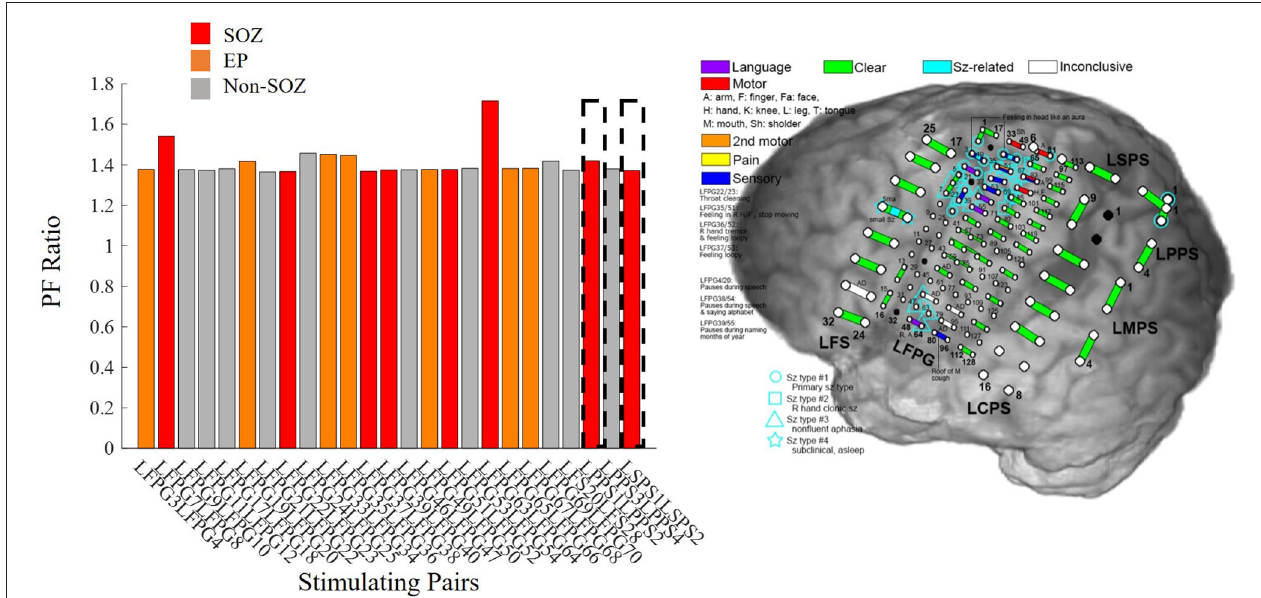
FIGURE 10 | Bar plot of PF ratios for Patient 5 with a high confidence statistic value according to the model, but an unsuccessful surgical outcome. The dotted boxes represent the regions that were resected. Red indicates electrode pairs in the clinically annotated seizure onset zone (SOZ), orange is early spread (EP), and gray are all others. Regions with high PF ratios were not resected because they were in eloquent cortex, possibly explaining the seizure